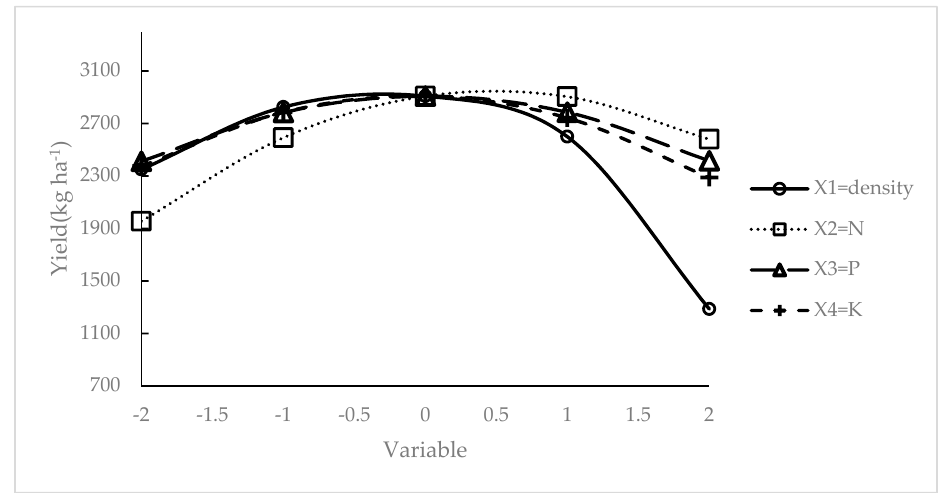
Figure 1. The effect of the factors ( X 1 = density, X 2 = N, X 3 = P, X 4 = K) on mean fiber yield for 2016 and 2017.